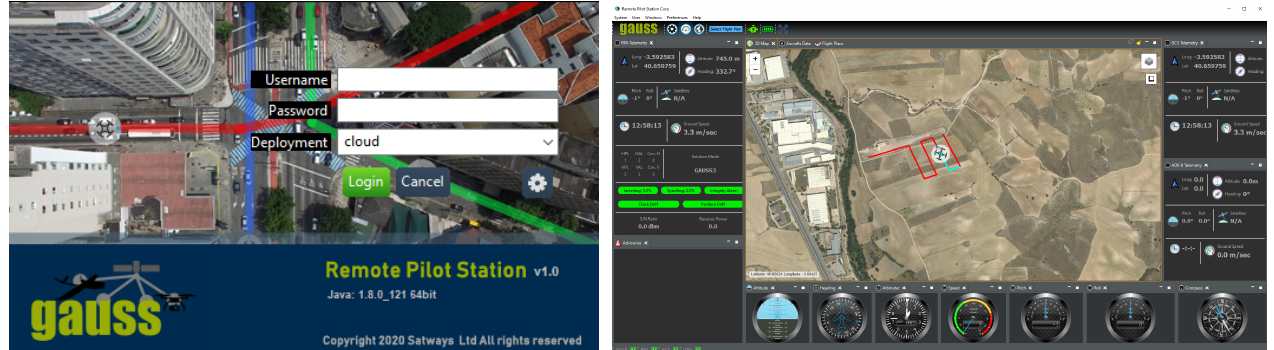
Figure 13. Screenshot of the graphical user interface developed by SATWAYS running on the RPS Client